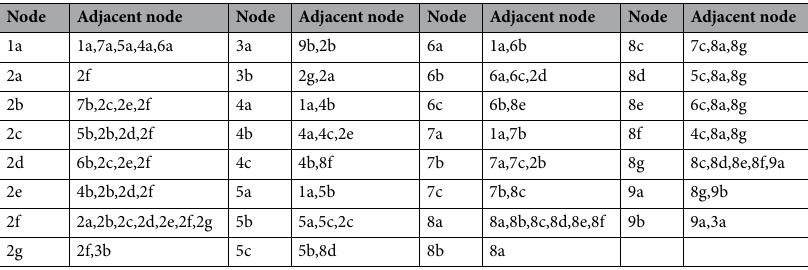
Table 1. Adjacency relationship of nodes in the feature graph.